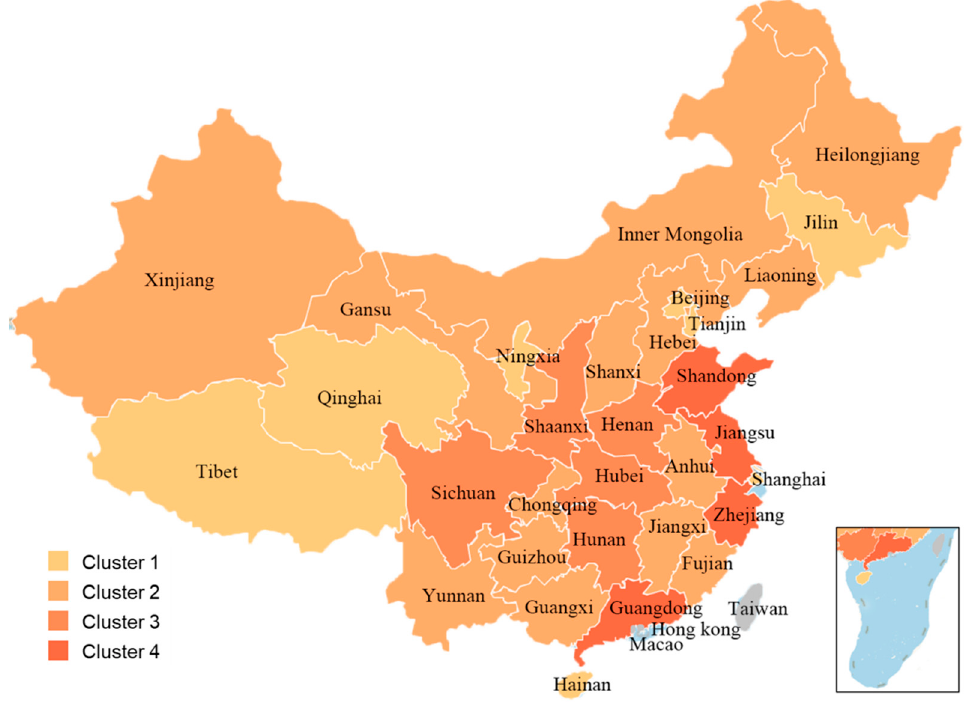
Figure 10. The geographic clustering results.